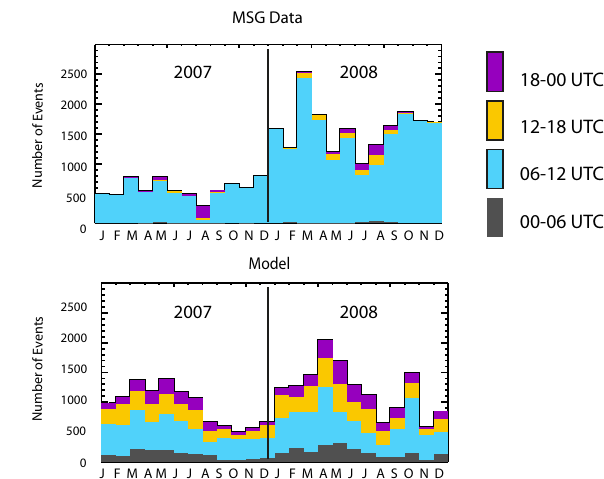
Fig. 1. Number of dust emission events in the Sahara for the years 2007 and 2008 derived from the MSG infrared dust index (top) and computed with the COSMO-MUSCAT model (bottom). The colors indicate the time of day when dust emission